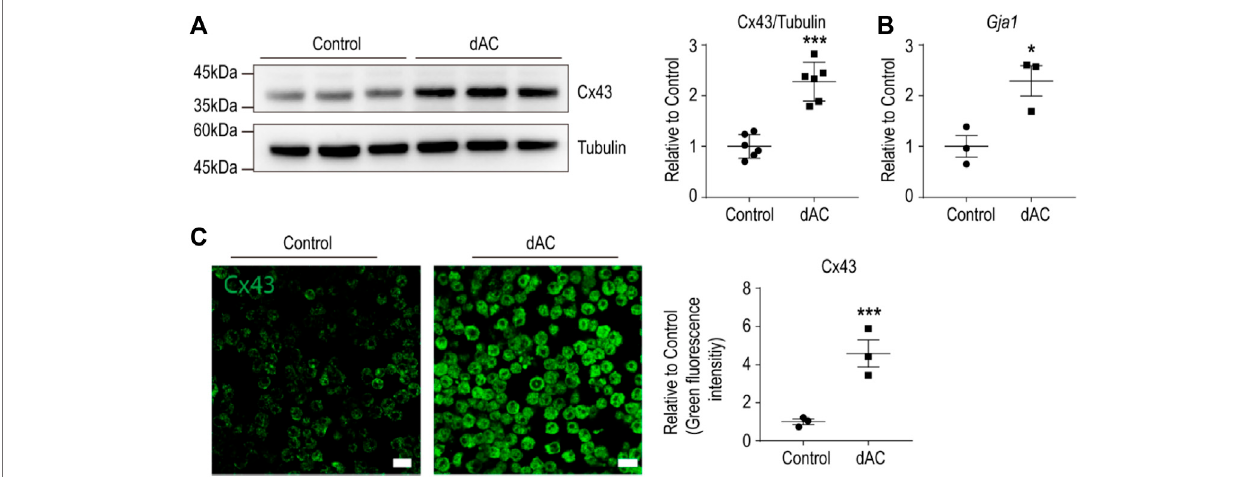
FIGURE2| Macrophagesco-culturedwithdyingadipocytes(dAC)upregulateCx43expression (A – B) ImmunoblotanalysisofCx43protein (A) andqPCRanalysis of Gja1 transcript levels (B) in F4/80 + macrophages isolated from gWAT co-cultured with dying adipocytes (dAC) for 24 h (A: n = 6, B: n = 3) (C) Immuno fl uorescence images of Cx43 staining in F4/80 + macrophages from gWAT co-cultured with or without dying adipocytes (dAC) for 24 h ( n = 3). Unpaired, two-tailed t-tests (* p < 0.05, *** p < 0.001), each point represents biological replicate. Data are presented as mean ± S.E.M.